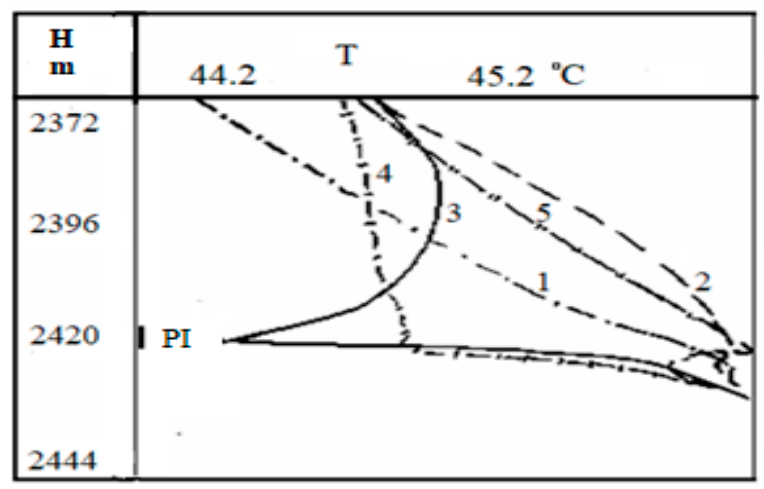
Figure 8. The results of well test. 1—background, before the compressor is switched on; 2—when the compressor is running; 3—immediately after shutting down the compressor and reducing the pressure in the well; 4 and 5, 1 and 2 h after the compressor is turned off (PI is the perforation interval) [28].